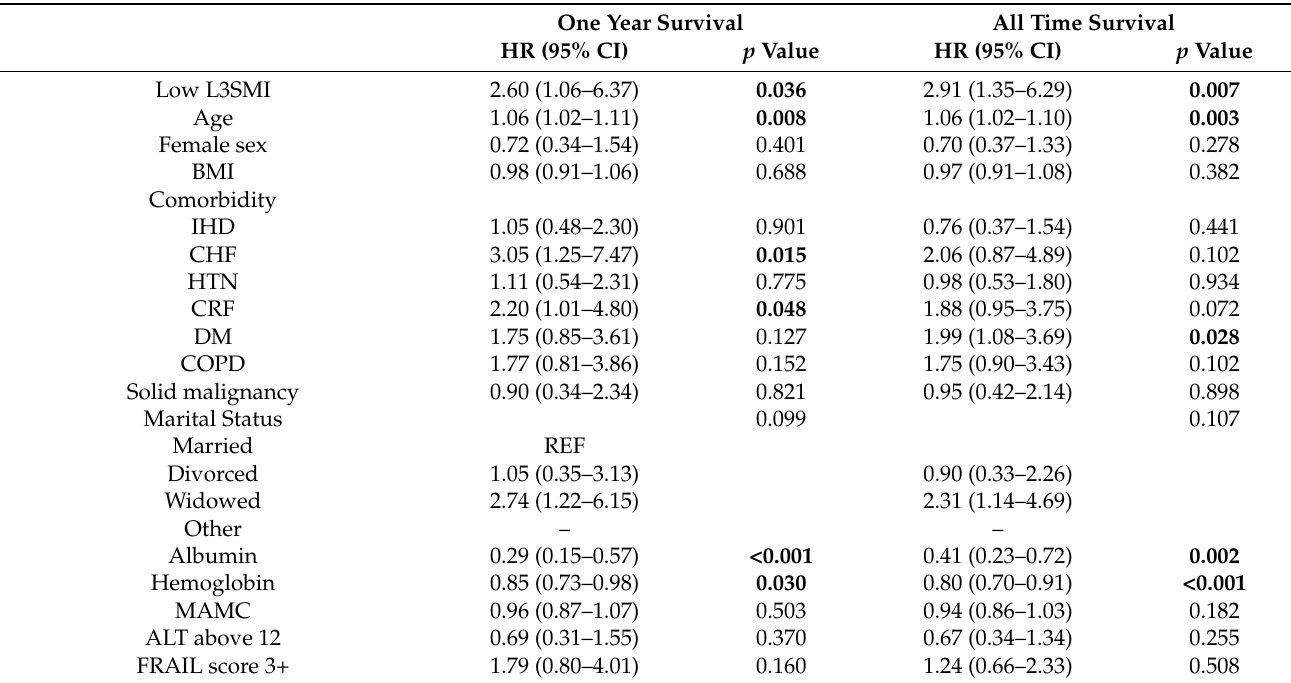
L3SMI: Lumbar Vertebrae 3 Skeletal Muscle Index, SD: Standard Deviation, BMI: Body Mass Index IQR: Interquar- tile range, CHF: Congestive Heart Failure, COPD: Chronic Obstructive Pulmonary Disease, CRF: Chronic